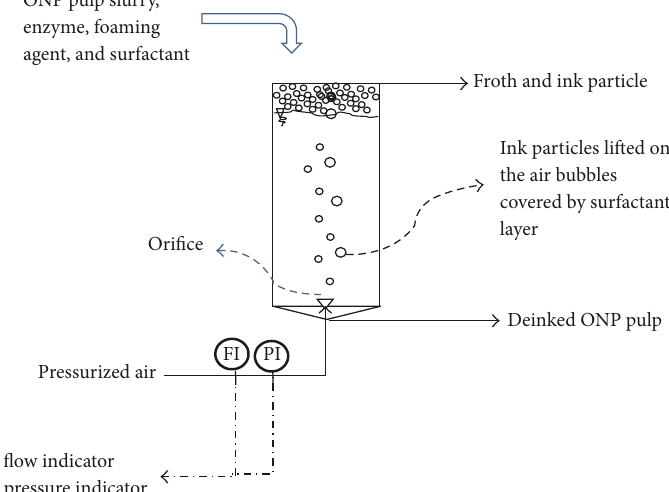
Figure 1: Schematic diagram of a flotation tank arrangement.